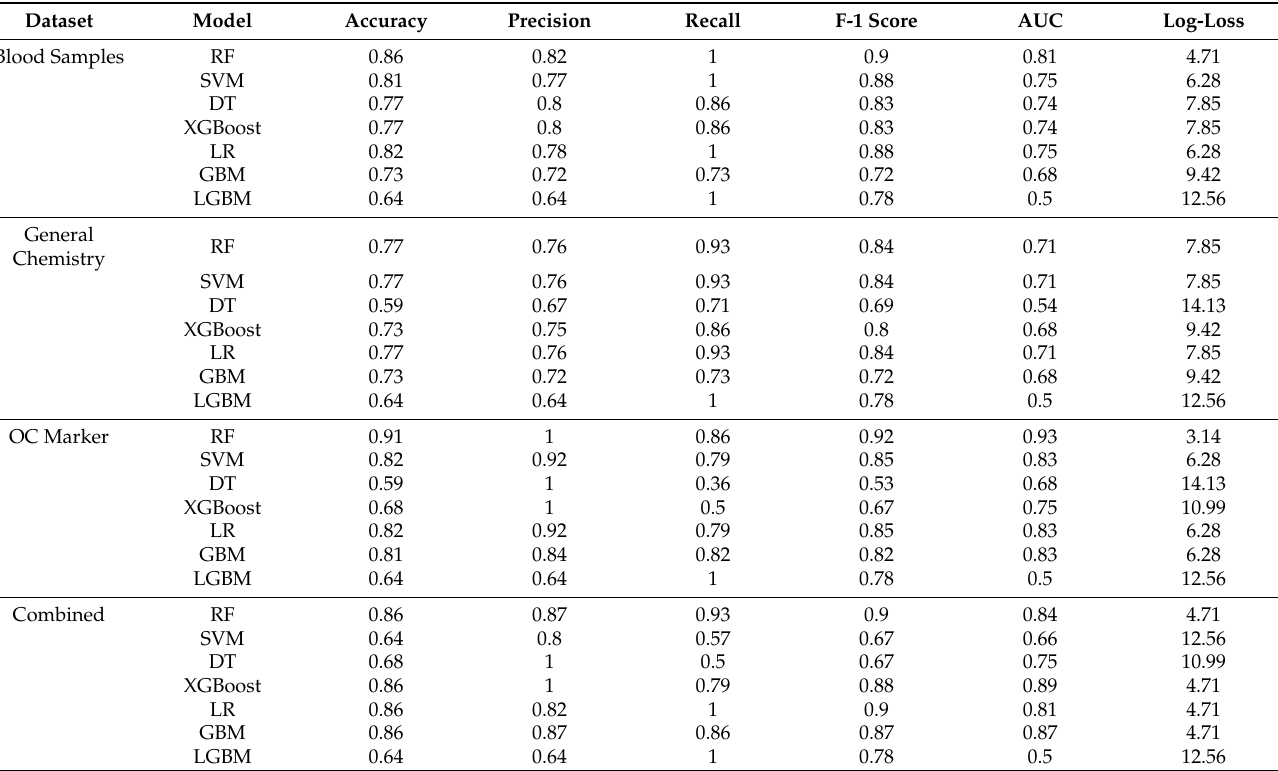
Table 4. Accuracy and evaluation matrices scores for each of the data groups for the dataset of 106